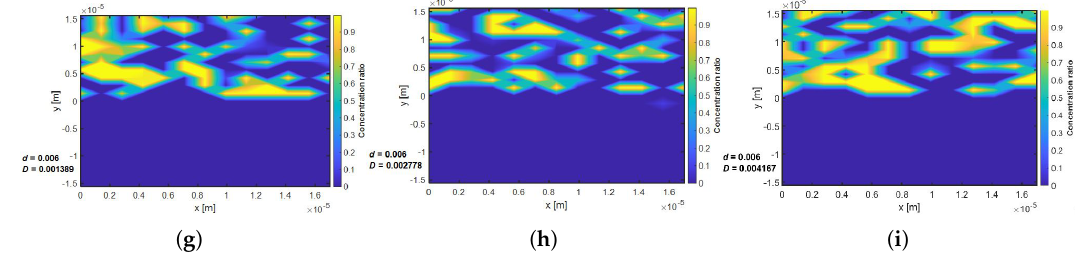
Figure 10. Contour plots of tracer concentration distribution within the porous media with linear drift ratio d = 0.006, 0.03 and 0.2 at 70 days.